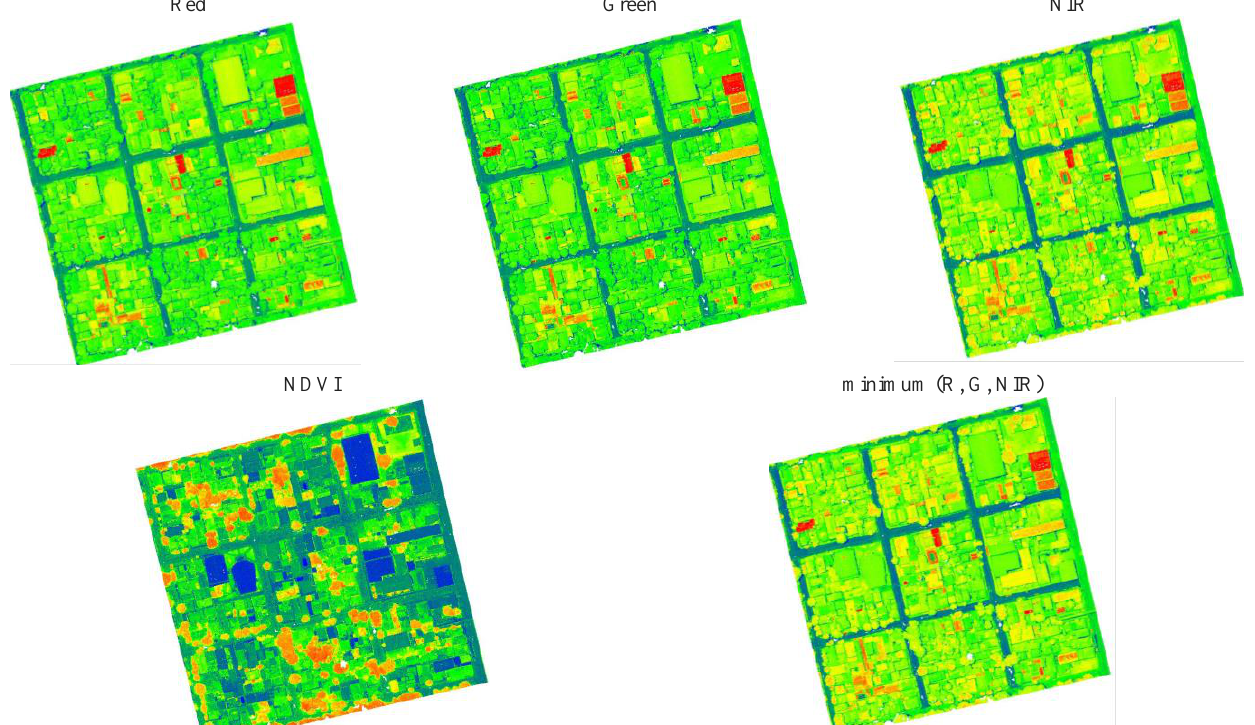
Figure 3. Radiometric features estimated for the generated